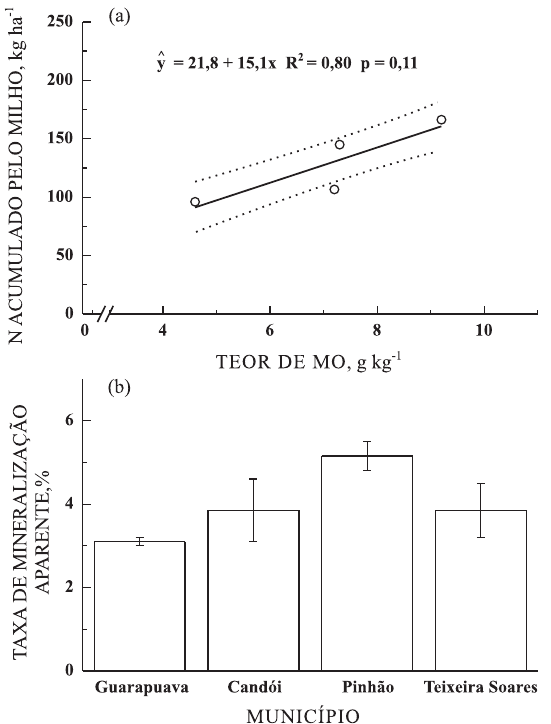
3. Relação entre o teor de matéria orgânica (MO, 0-10 cm) do solo e a quantidade de N acu-